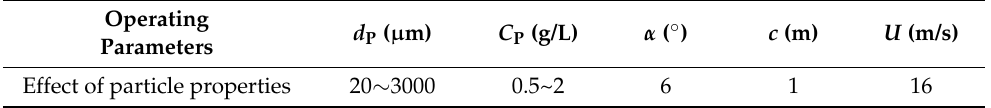
Table 5. Operating conditions of the simulation cases.